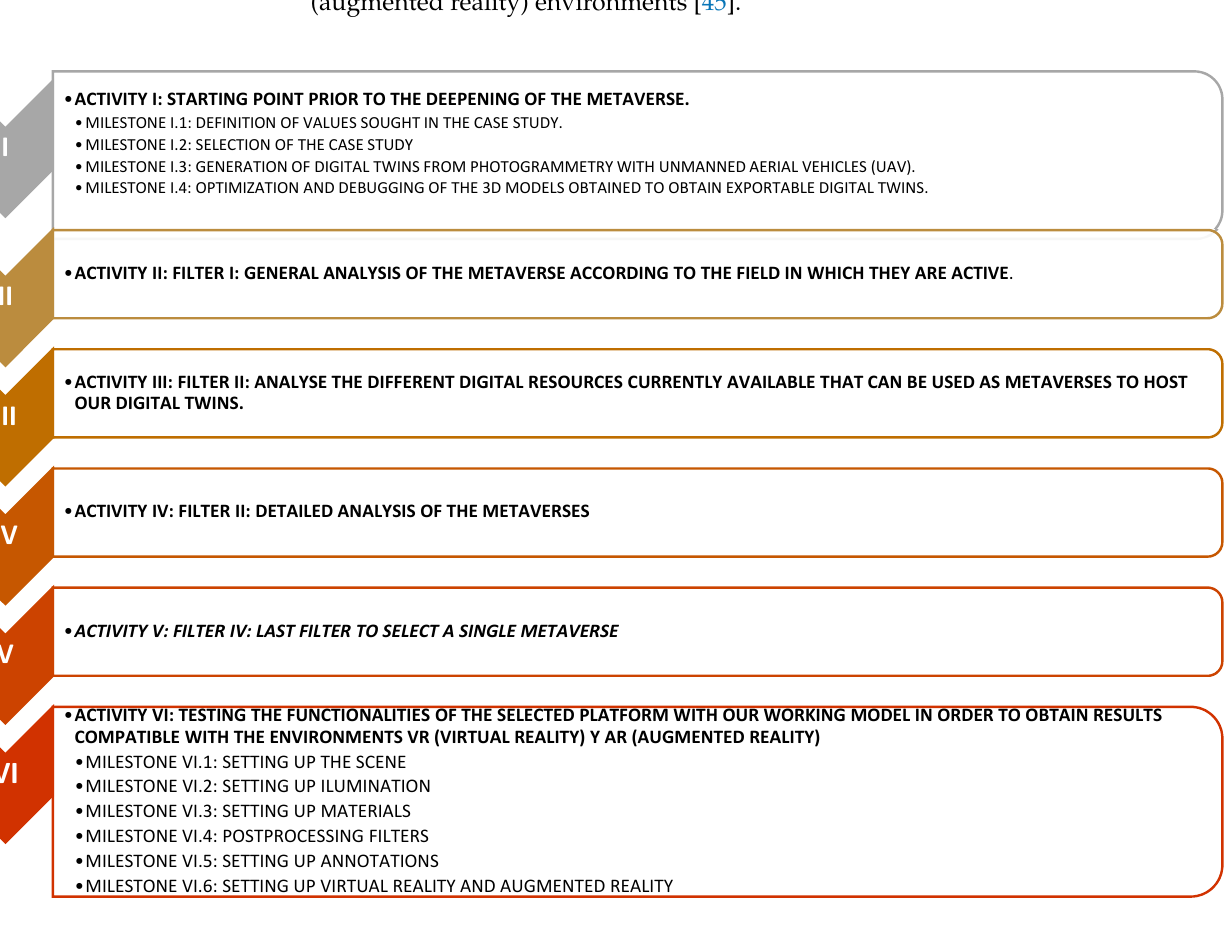
Figure 5. Schematization of work activities and milestones.